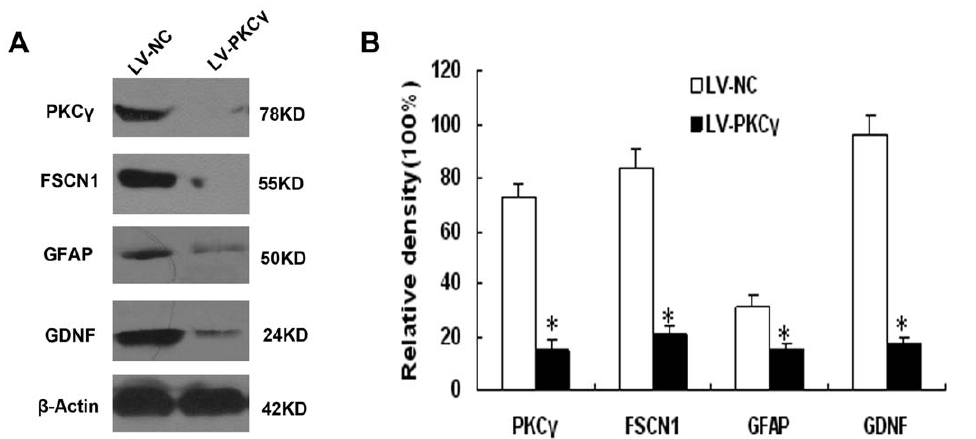
Figure 2. Effect of LV-PKCa˜ treatment on expression of proteins in the spinal cords of morphine-tolerant rats. (A) Western blot detection of PKCa˜ and other differentially expressed proteins. (B) The expression level for each protein was estimated by densitometry, and is shown as a ratio to the loading control, aˆ-actin. Data are presented as mean 6 SD. * P , 0.05, compared with the corresponding value in the LV-NC group.